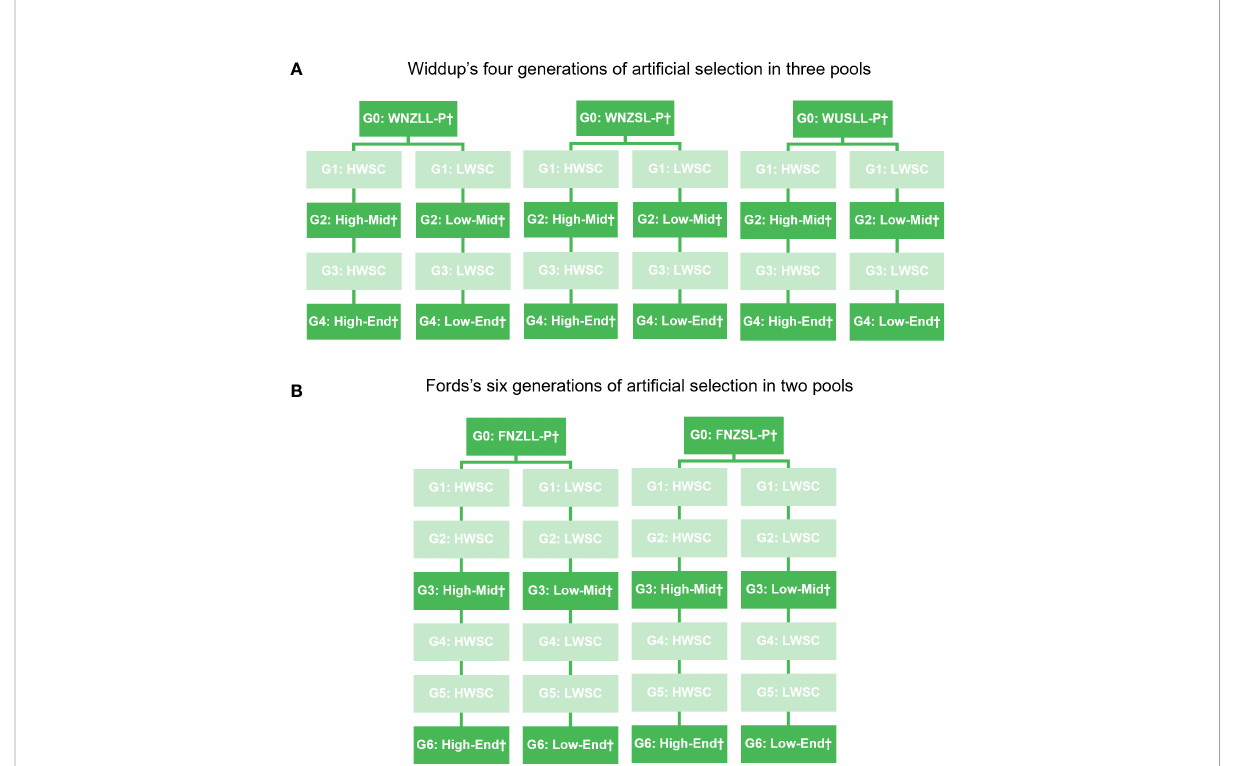
FIGURE 1 Schematic representation of white clover populations from the (A) Widdup et al. (2010) and (B) Ford breeding programmes. G, generation; W, Widdup; F, Ford; NZ, New Zealand/Aotearoa; US, United States of America; LL, large leaf; SL, small leaf; P, Parent generation; HWSC and High, high water-soluble carbohydrate (WSC); LWSC and Low, low WSC; Mid, Middle generation; and End, End generation. † denotes populations used in phenotyping and genotyping